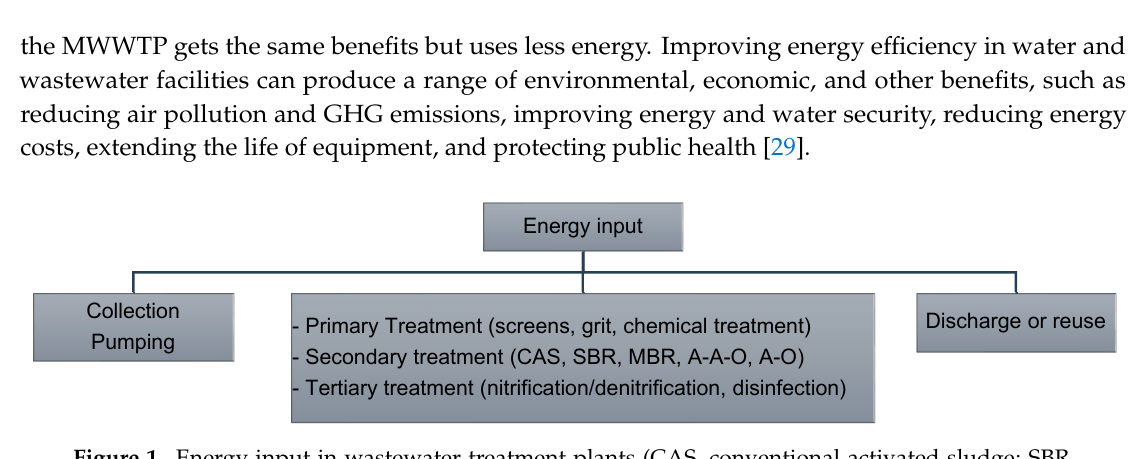
Figure 1. Energy input in wastewater treatment plants (CAS, conventional activated sludge; SBR, sequencing batch reactor; MBR, membrane bioreactor; A-A-O, anaerobic-anoxic-oxic system; A-O, anaerobic-oxic system).